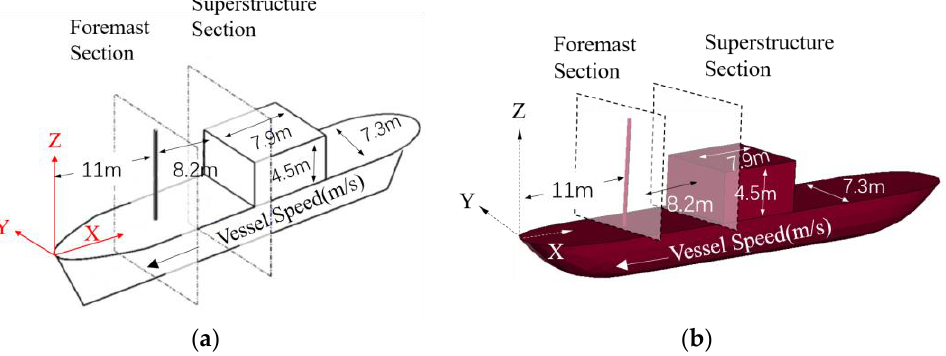
Figure 3. This figure shows the model built imitating the Dehghani model: ( a ) schematic of the MFV used as the ship model for the model of 3-D spray cloud by Dehghani (2018) [40], and ( b ) schematic of the MFV used as the ship model for the model of 3-D spray cloud by using SPH method. Table 1. The calculation parameters of wave impacting hull forming ocean droplet model calcula- tions.